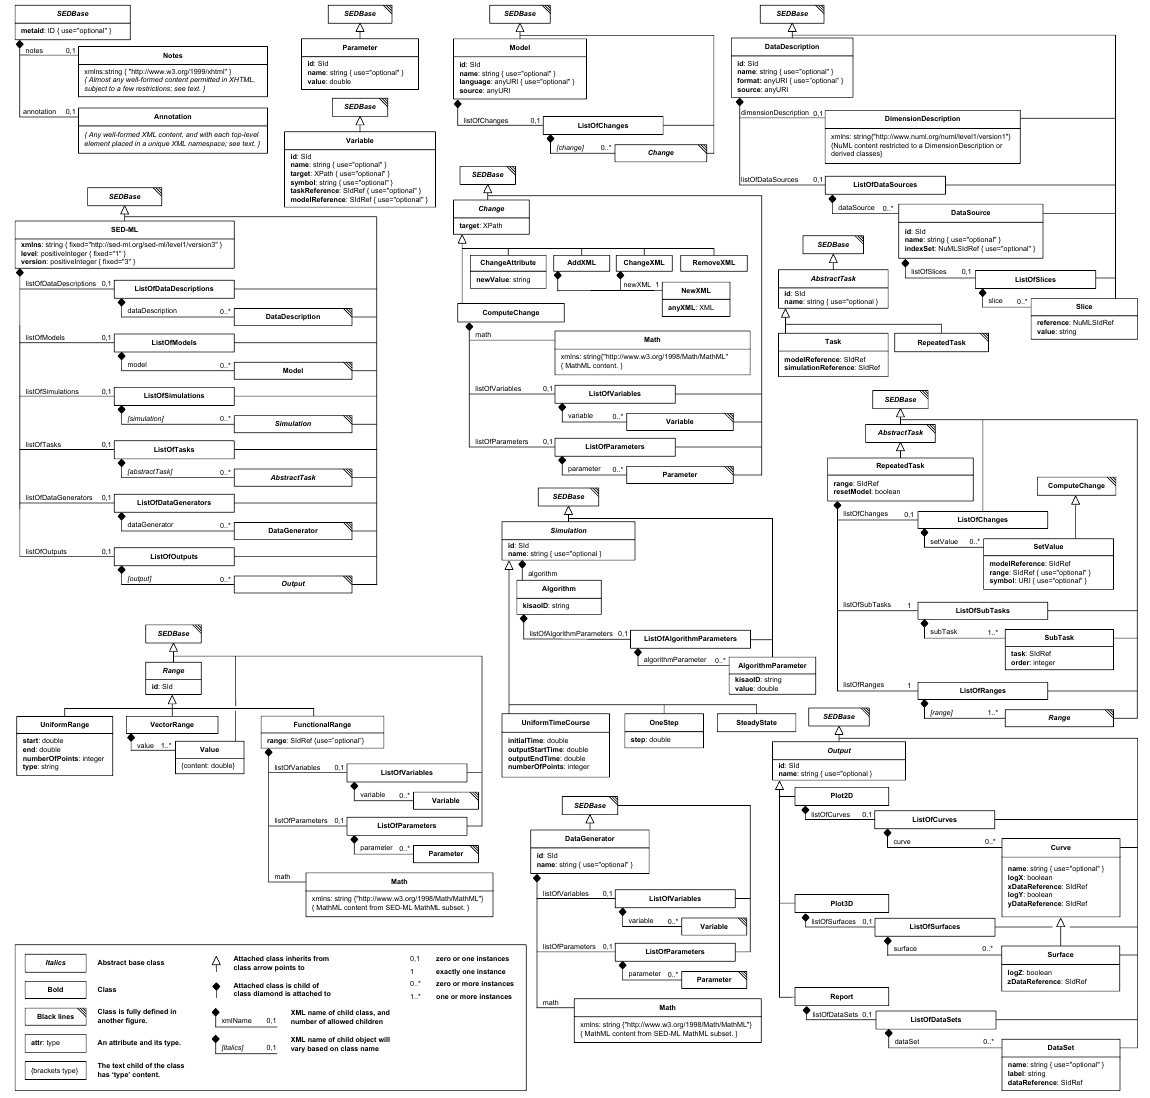
Figure 2.1: The SED-ML Level 1 Version 3 UML class